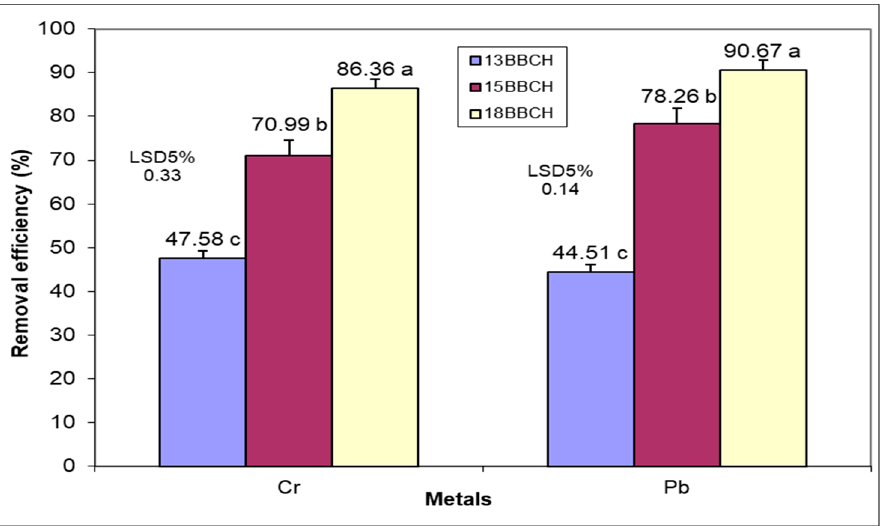
Figure 3. RE of Cr and Pb in different development stages of S. perfoliatum grown in heavy metal Ps . Error bars represents SE. Different letters (a, b, c) indicate significant differences ( p < 0.05) between stages .